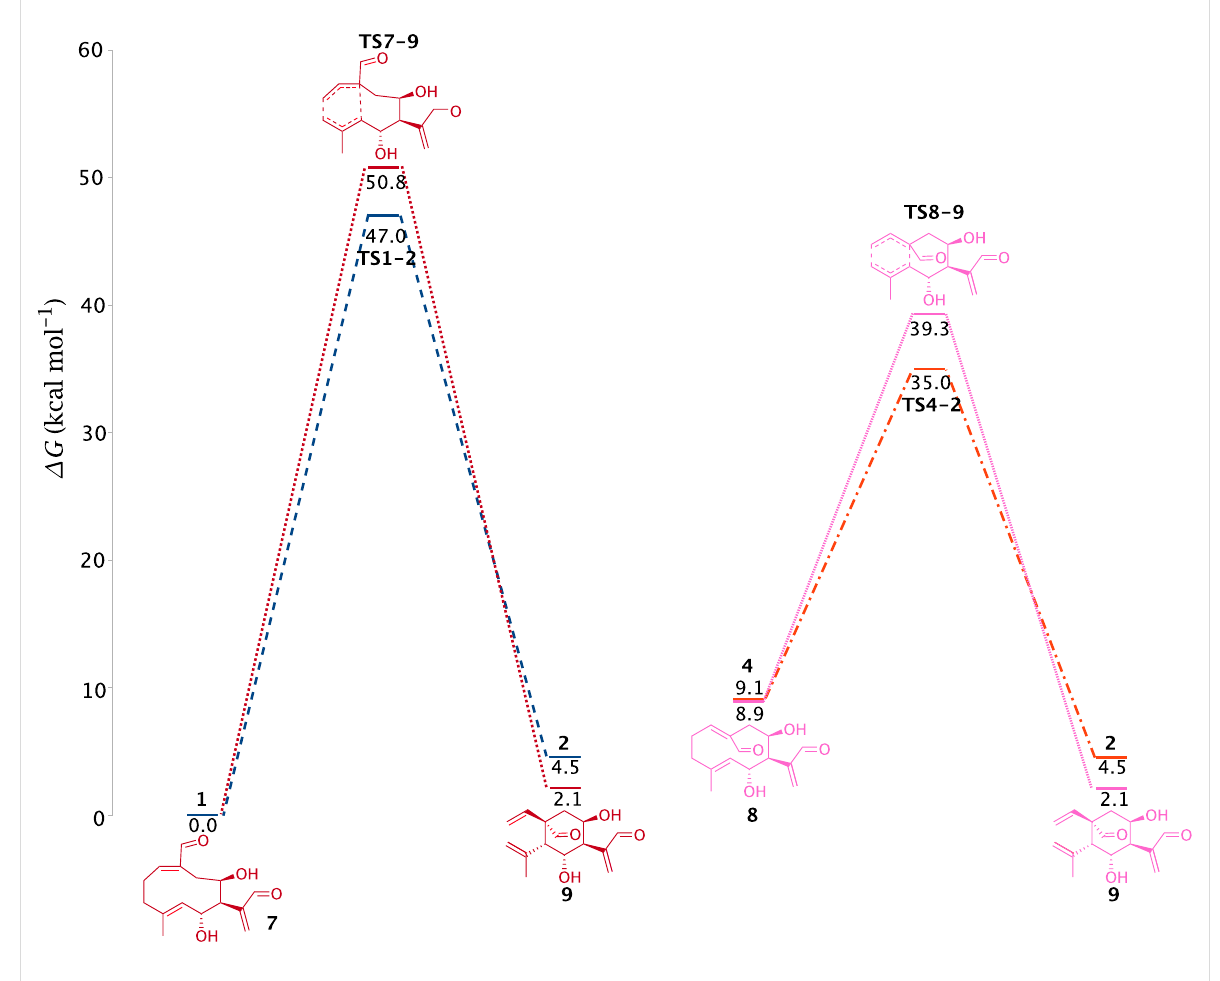
Figure 3: Reaction paths of the Cope rearrangements of closed (dark blue and orange) and open (red and pink) γ -lactone ring. Relative free ener- gies in